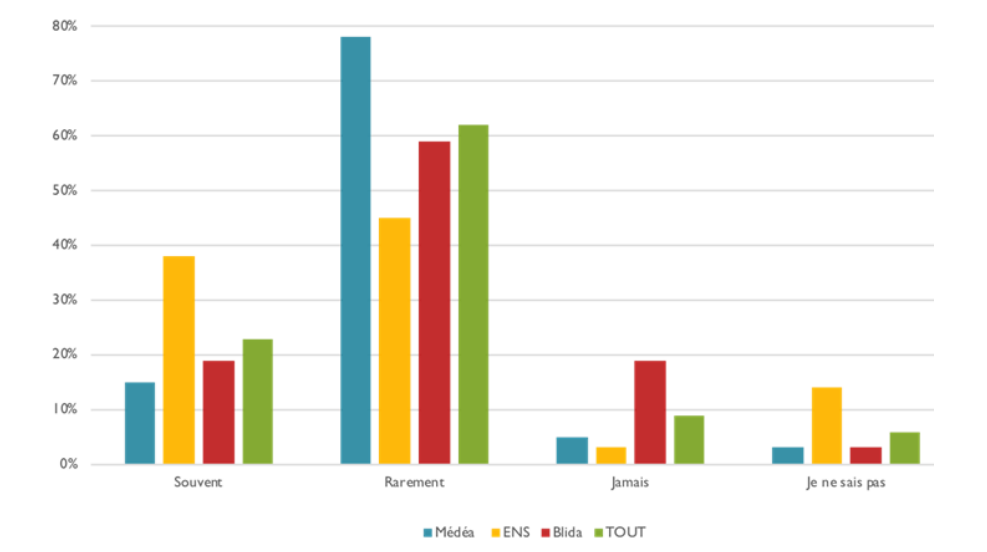
Table 2. La prise en compte du concept de modèle.